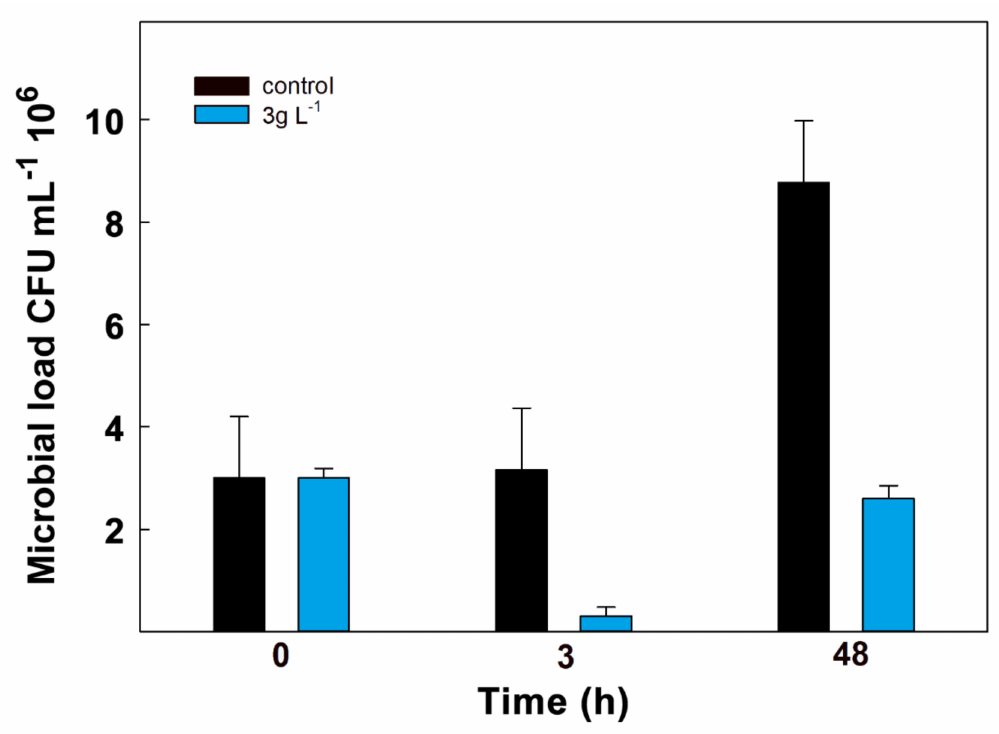
Figure 7. Microbial contamination reduction in Chlorella sorokiniana cultured with 0 or 3 g L − 1 of sodium bicarbonate. Analysis performed three times, after 0, 3, and 48 h after bicarbonate